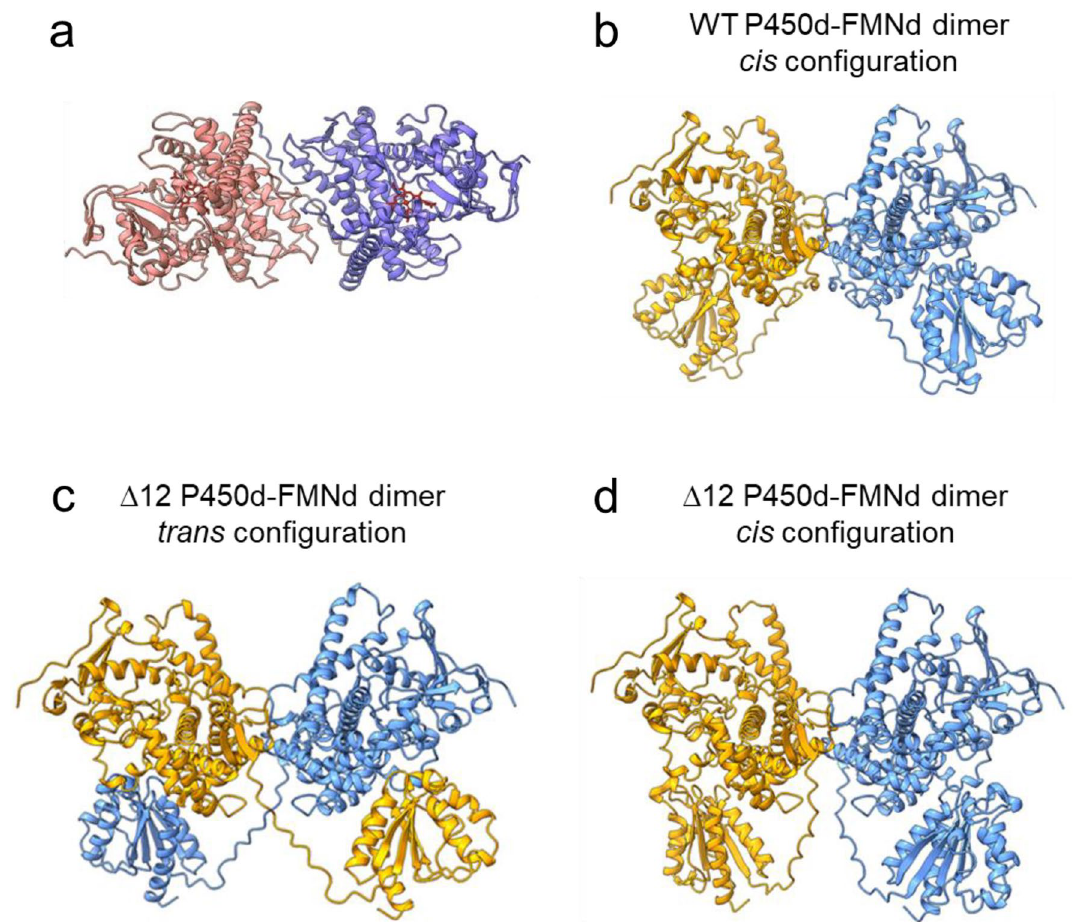
Figure 2. AF2A modelling of CYP102A1 P450d-FMNd parts. ( a ), Predicted AF2A structure for the P450d dimer (CYP102A1 residues 2–458). The two heme cofactors are in red. ( b ), Predicted AF2A structure for the P450d-FMNd dimer (CYP102A1 residues 1–631). ( c–d ), Predicted AF2A structures for the corresponding variant featuring a 12-residue ( 457 GGIPSPSTEQSA 468 ) truncated P450d-FMNd linker. Both crossed ( trans ) and non-crossed ( cis ) predicted configurations are shown. Domains belonging to the same polypeptide chain share the same